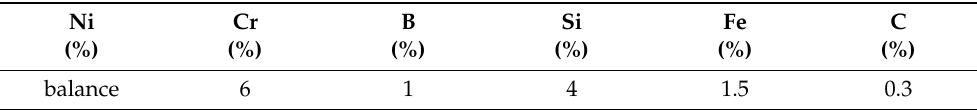
Figure 1. SE micrograph ( a ) and EDX spectrum ( b ) of the NiCrBSi powder. Table 1. Chemical composition of the